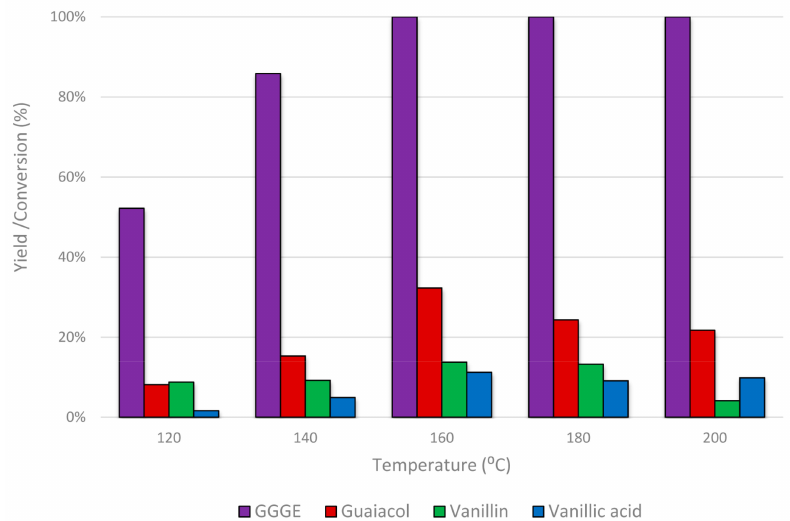
Figure 3. Temperature study for the GGGE oxidation with 5 wt.% Ru / Al 2 O 3 (3) catalyst. Reaction